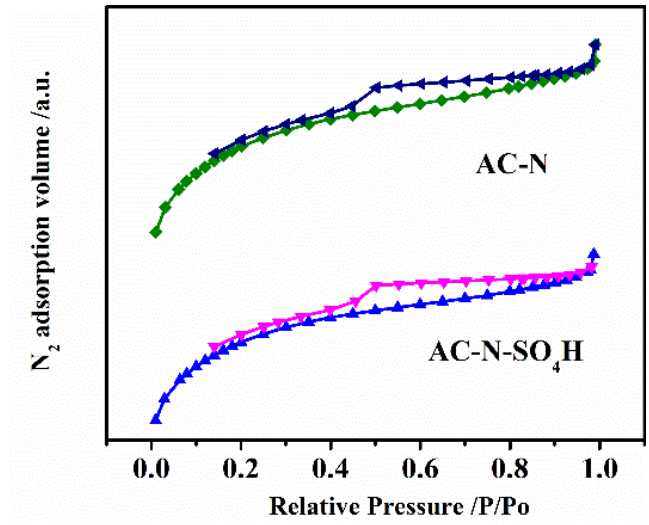
Figure 3. N 2 adsorption–desorption isotherms for AC-N and AC-N-SO 4 H.